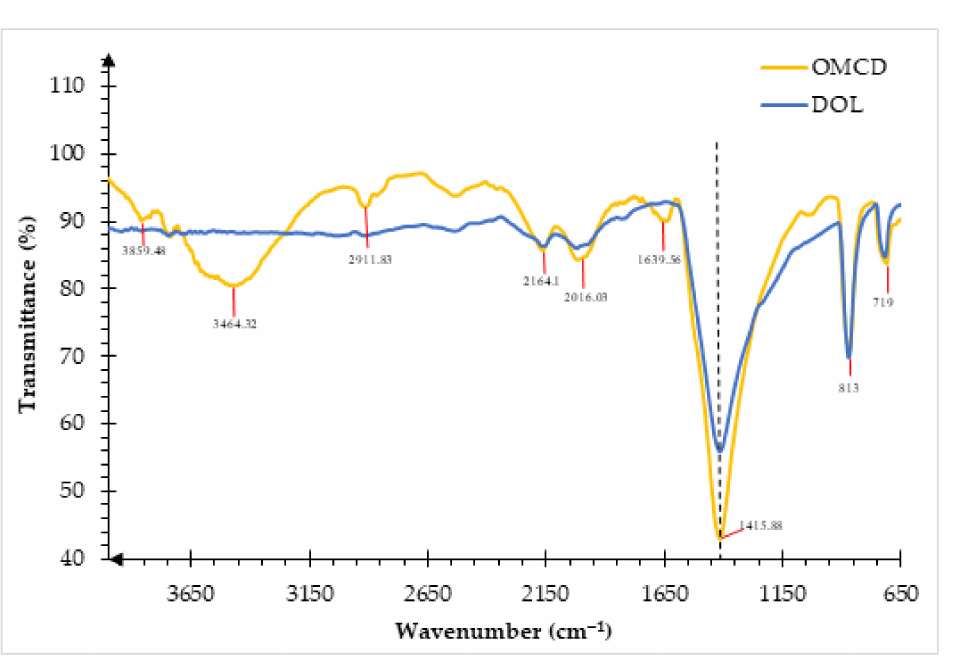
Figure 2. FTIR spectra of DOL and OMCD